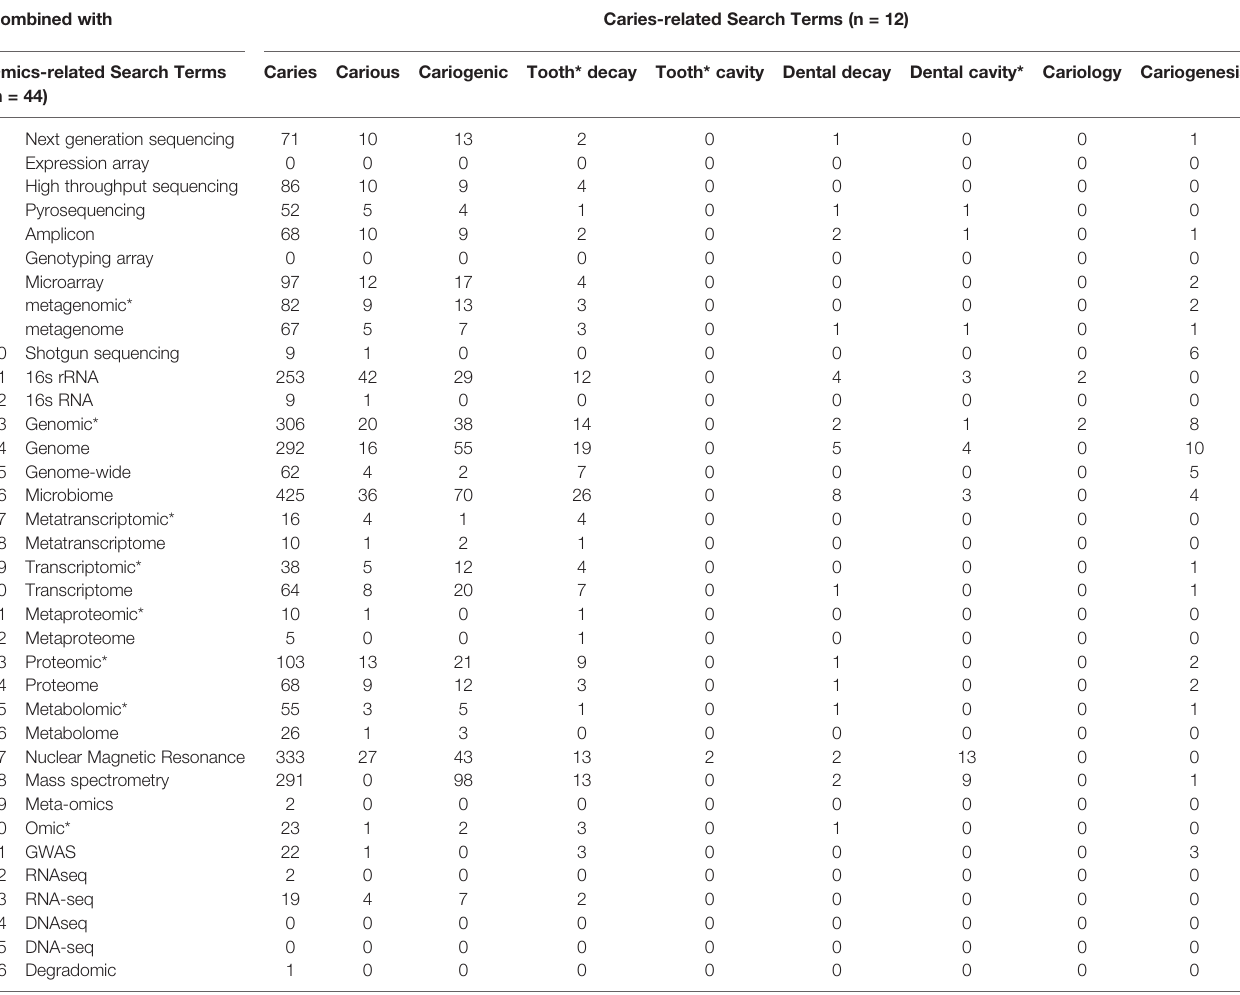
TABLE 1 | The search terms and their combinations between dental caries- and omics-related terms used for data extraction from Elsevier's Scopus database. Combined with Caries-related Search Terms (n = 12) Omics-related Search Terms (n =